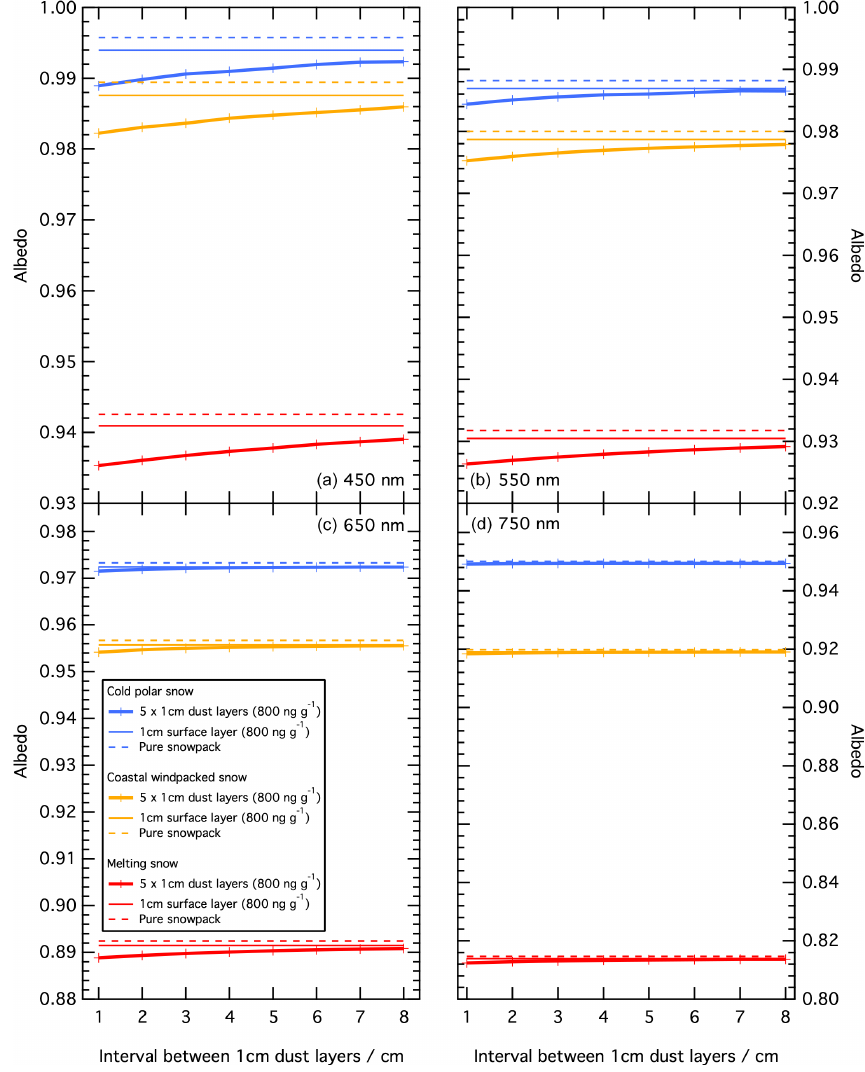
Figure 10. Albedo of three snow types (40cm thick) containing five layers of 800ngg − 1 dust with varying intervals from 1 to 8cm. The dotted line represents a pure snowpack containing a dust mass ratio of 1ngg − 1 of Asian dust. The thin line represents a pure snowpack with a 1cm thick surface layer containing 800ngg − 1 of Asian dust. The thick line and markers represent a pure snowpack with 5 layers each containing 800ngg − 1 of Asian dust. The x axis shows the spacing between the 5 layers, varying between 1 and